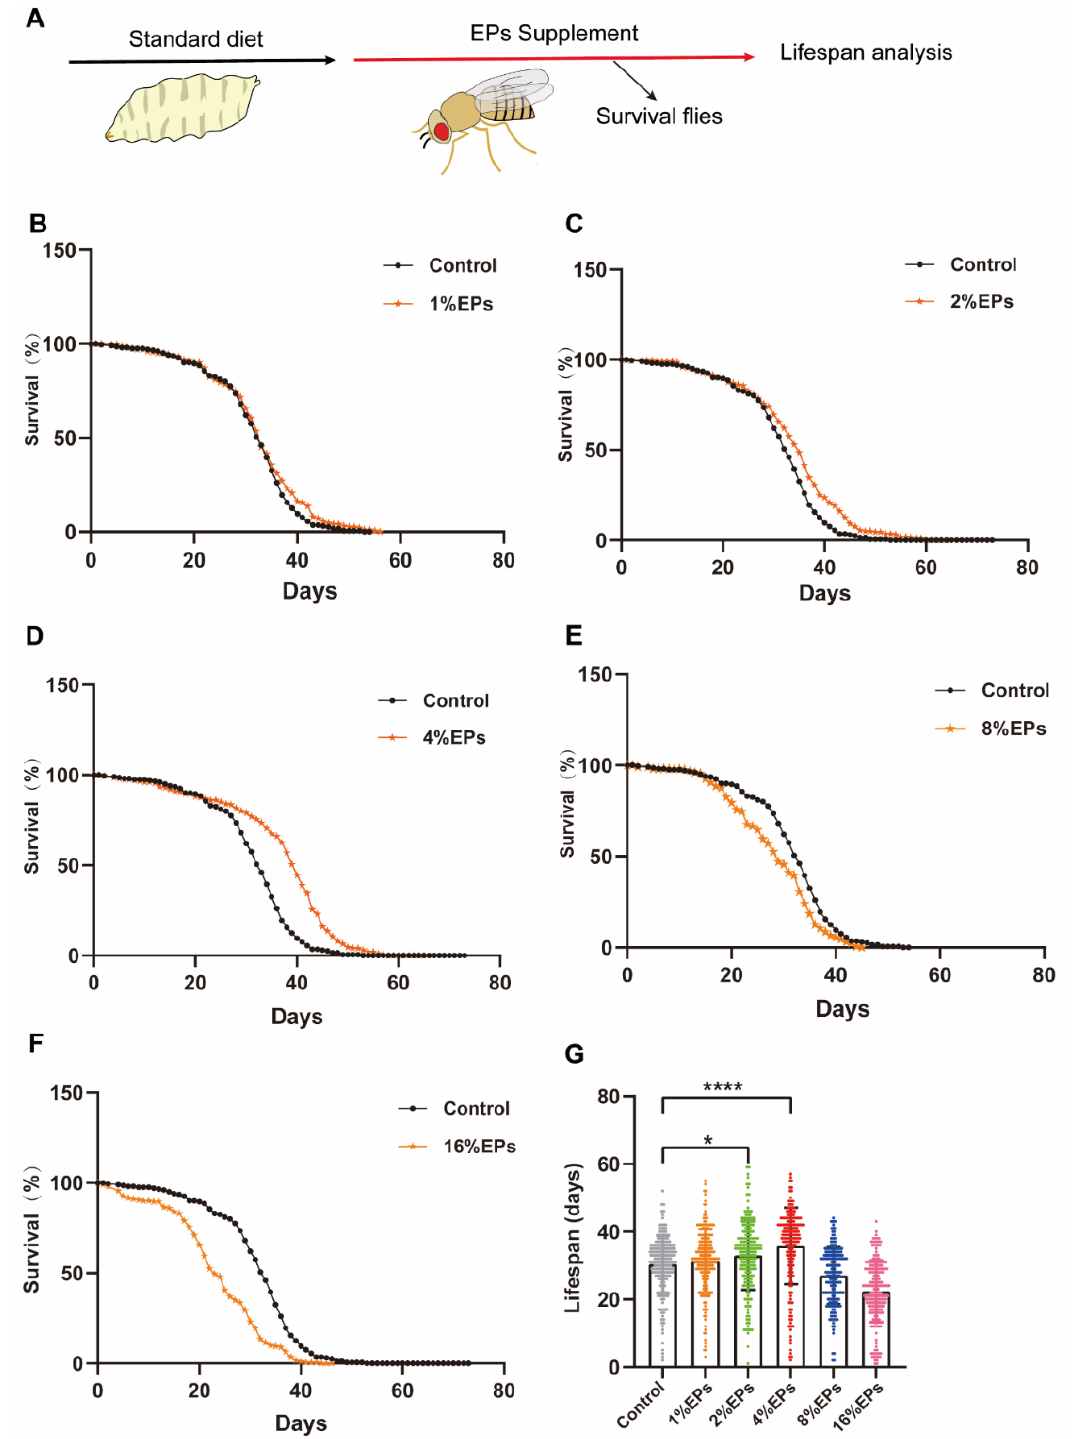
Figure 2. EPs with proper concentrations promoted the survival and extended the life span of Drosophila. ( A ) Schematic diagram of the experiment. ( B – F ) Percentage survival of flies in the control group fed with standard medium and groups supplemented with 1%, 2%, 4%, 8%, and 16% EPs. ( G ) Life span of flies in the control group and EP groups with different concentrations. Mean ± SEM ( n = 200). The details of the statistical tests used in this and all subsequent figures are given in theSection 4 . * p < 0.05 ， **** p < 0.0001.